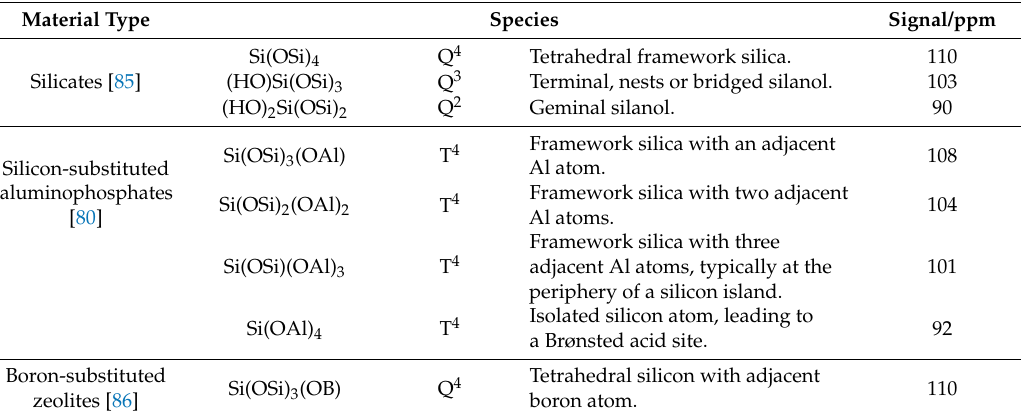
Table 3. Typical 29 Si-NMR assignments for zeotype Beckmann rearrangement